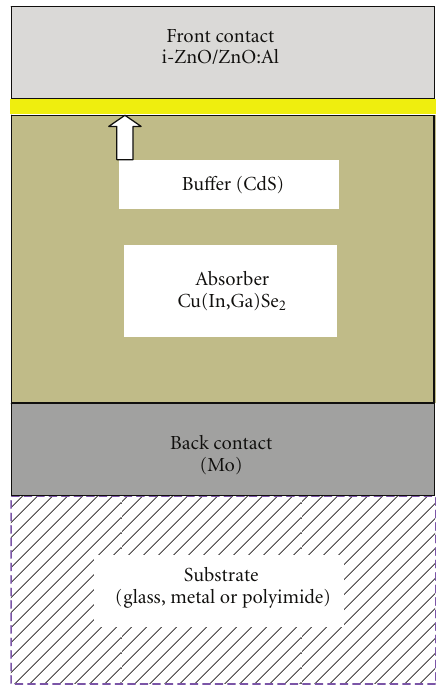
Figure 1: Schematic cross-section of a chalcopyrite-based thin-film solar cell. Typical materials for the individual parts of the cell are given in brackets.